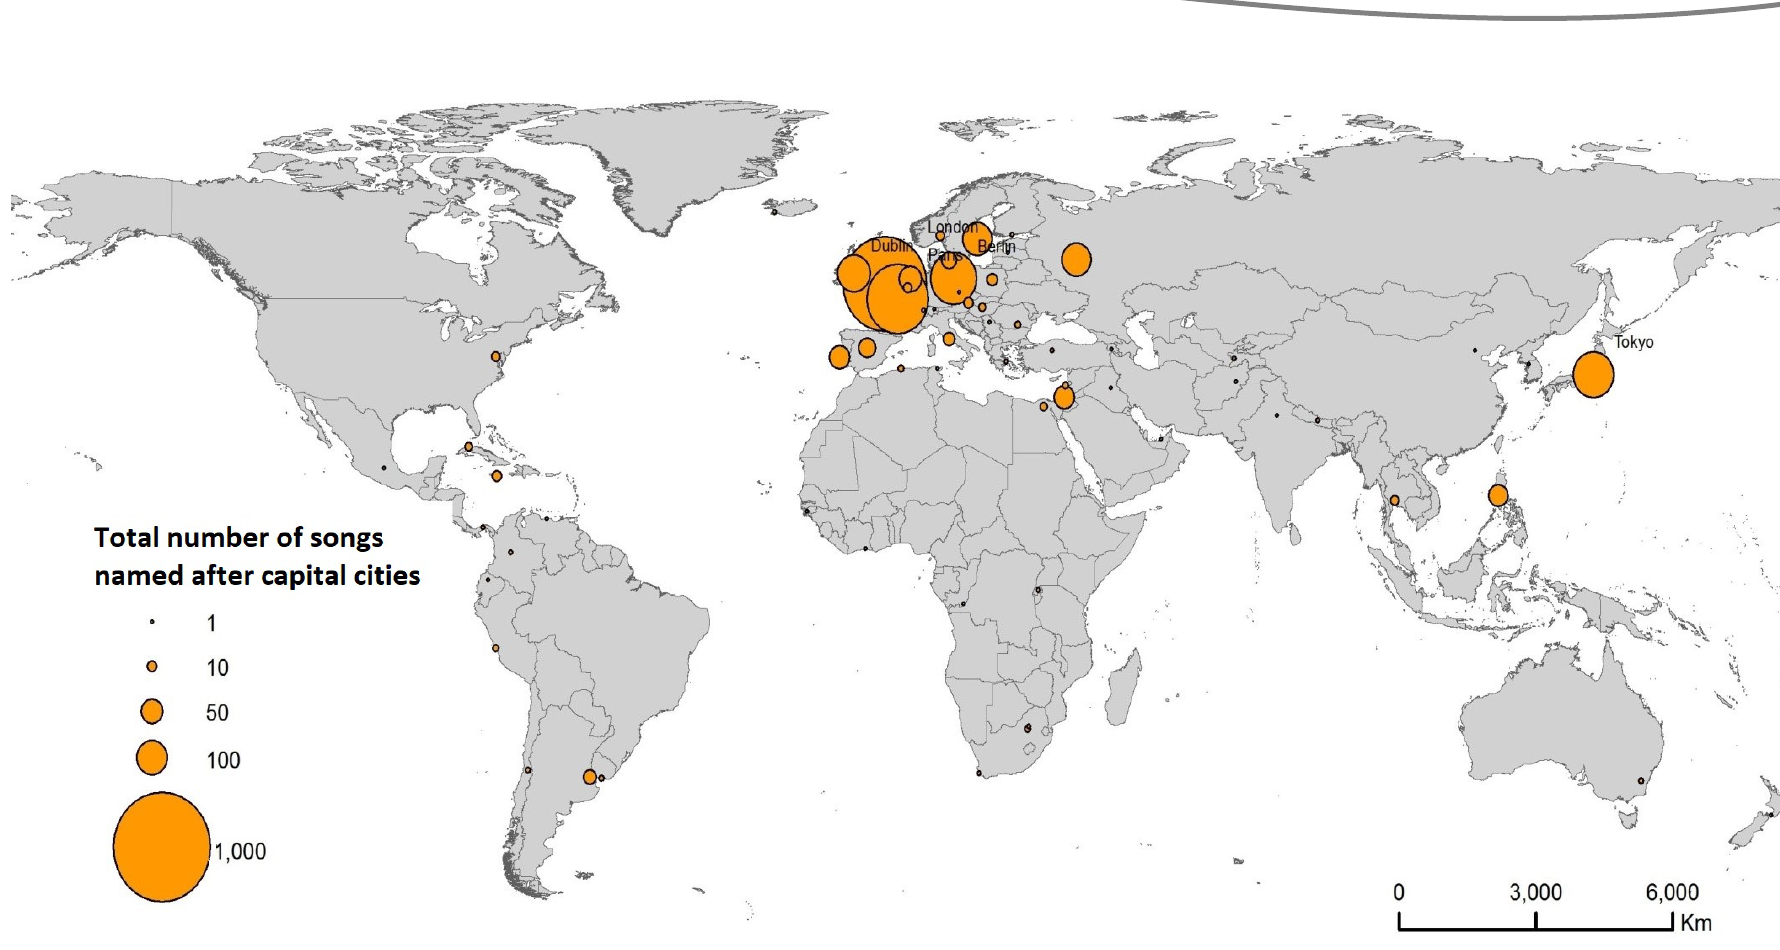
Figure 3: Songs featuring capital cities in their